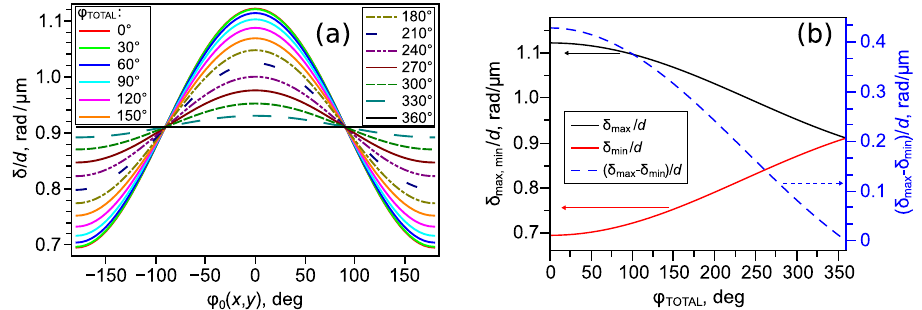
Figure 3. The dependencies of the ratio δ/ d on the azimuthal angle ϕ 0 ( x , y ) calculated for the some ϕ TOTAL twist angles ( a ), the dependencies of δ max / d , δ min / d and (δ max − δ max )/ d on the total twist angle ϕ TOTAL ( b ). The calculations were performed for the angles α = 5.33 ◦ , θ d / 2 = 40 ◦ , the light wavelength (cid:31) = 546 nm, and the refractive indices of LN-396.